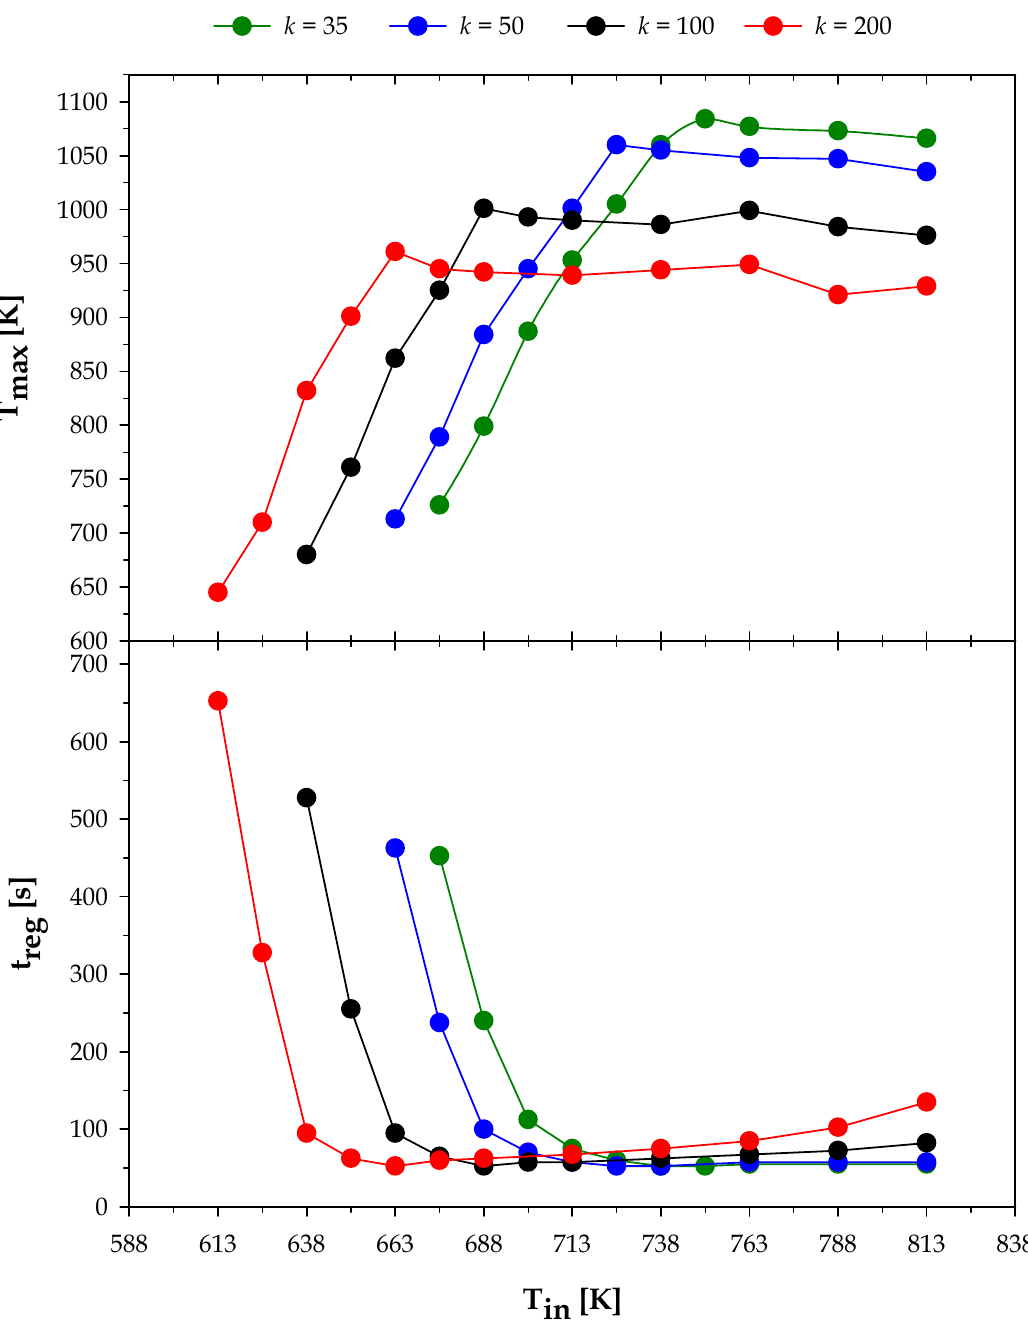
Figure 11. Maximum temperature, T max , and time for filter regeneration, t reg , versus inlet gas temperature, T in , at di ff erent values of k